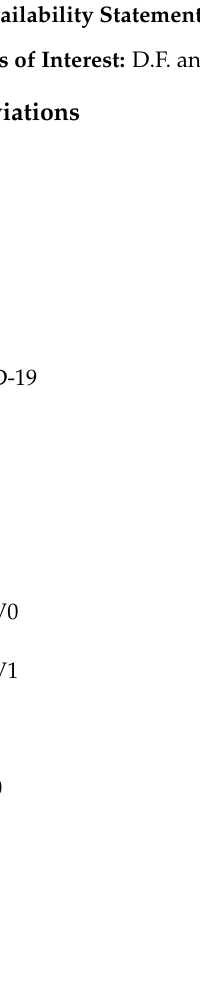
the control arms; Table S2: Microbial community composition at OTU level for the control arms; Table S3: Distal microbial community composition at family level for the AB and LAC10 arms; Table S4: Proximal microbial community composition at OTU level for the AB, LAC5 and LAC10 arms; Table S5: Distal microbial community composition at OTU level for the AB, LAC5 and LAC10 arms; Table S6: Proximal microbial community composition at family level for the AB and LAC10V0 arms; Table S7: Proximal microbial community composition at family level for the AB and LAC10V1 arms; Table S8: Distal microbial community composition at family level for the AB and LAC10V0 arms; Table S9: Distal microbial community composition at family level for the AB and LAC10V1 arms; Table S10: Proximal microbial community composition at OTU level for the LAC5V0, LAC10V0, LAC5V1 and LAC10V1 arms; Table S11: Distal microbial community composition at OTU level for the LAC5V0, LAC10V0, LAC5V1 and LAC10V1